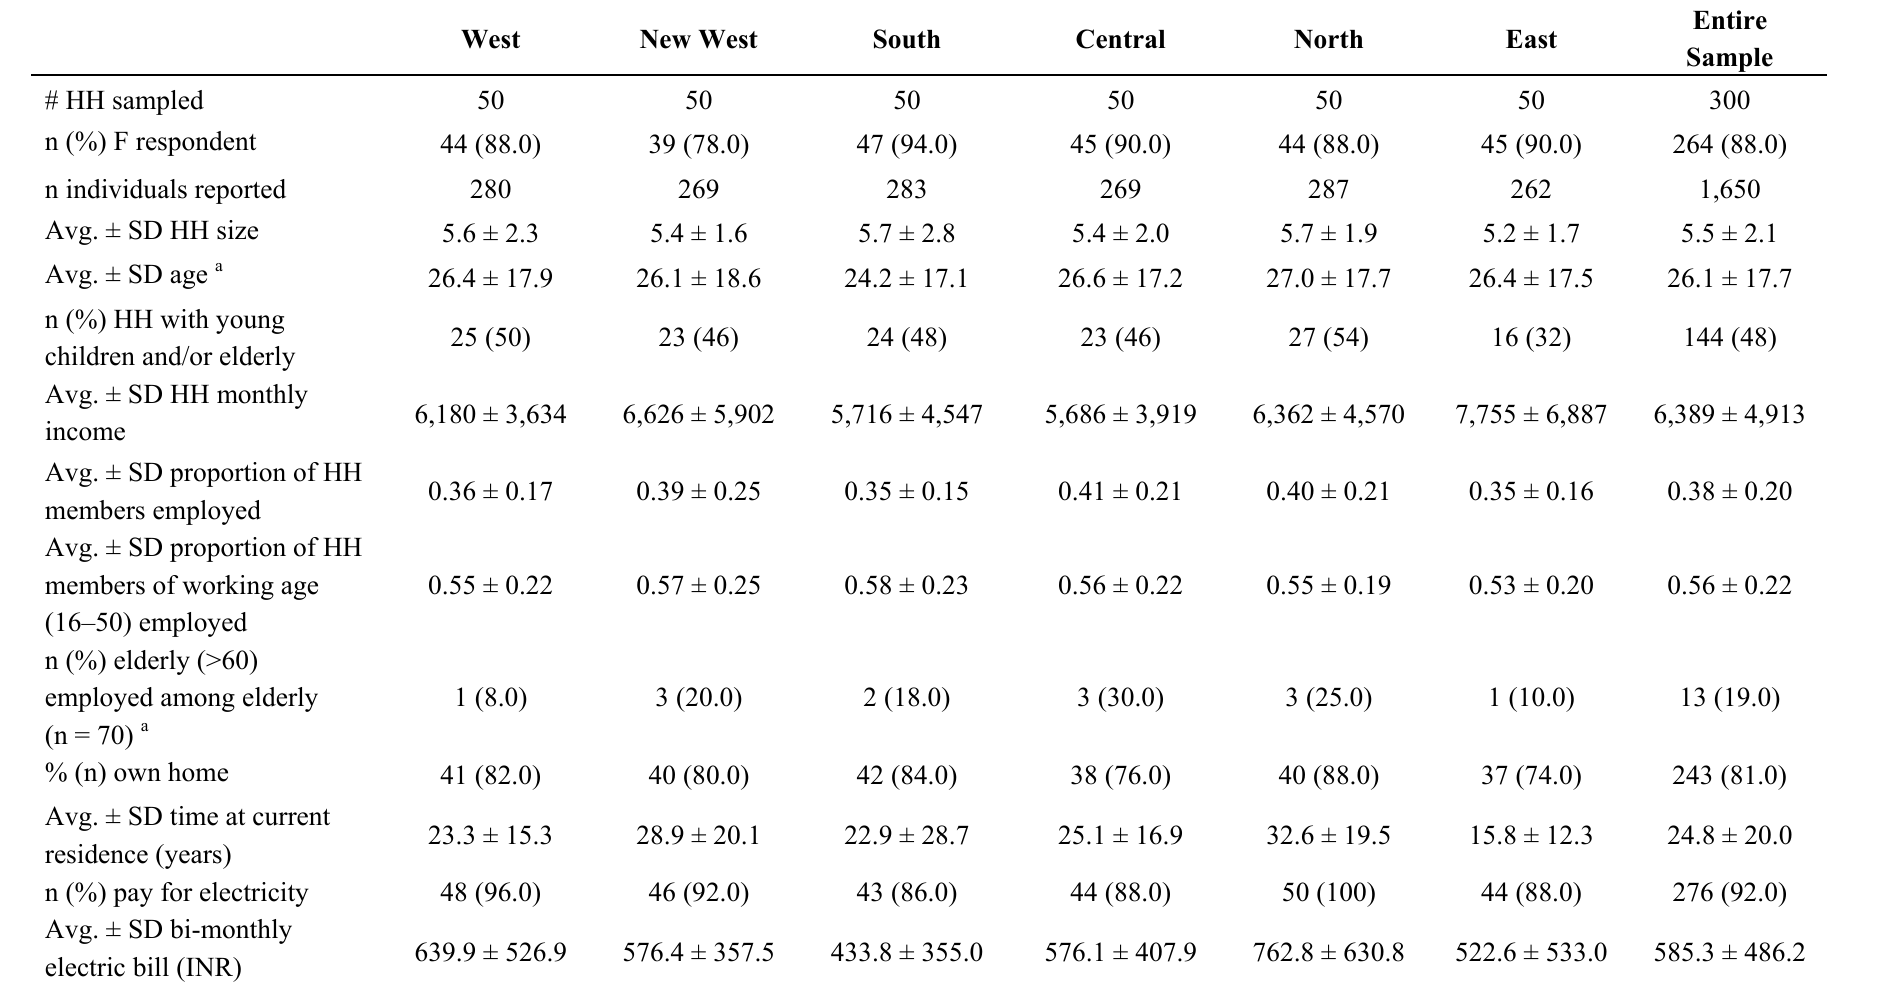
Table 1. Household demographics of the sampled Ahmedabad slum dwellers across six city zones (household N = 300, individual N =